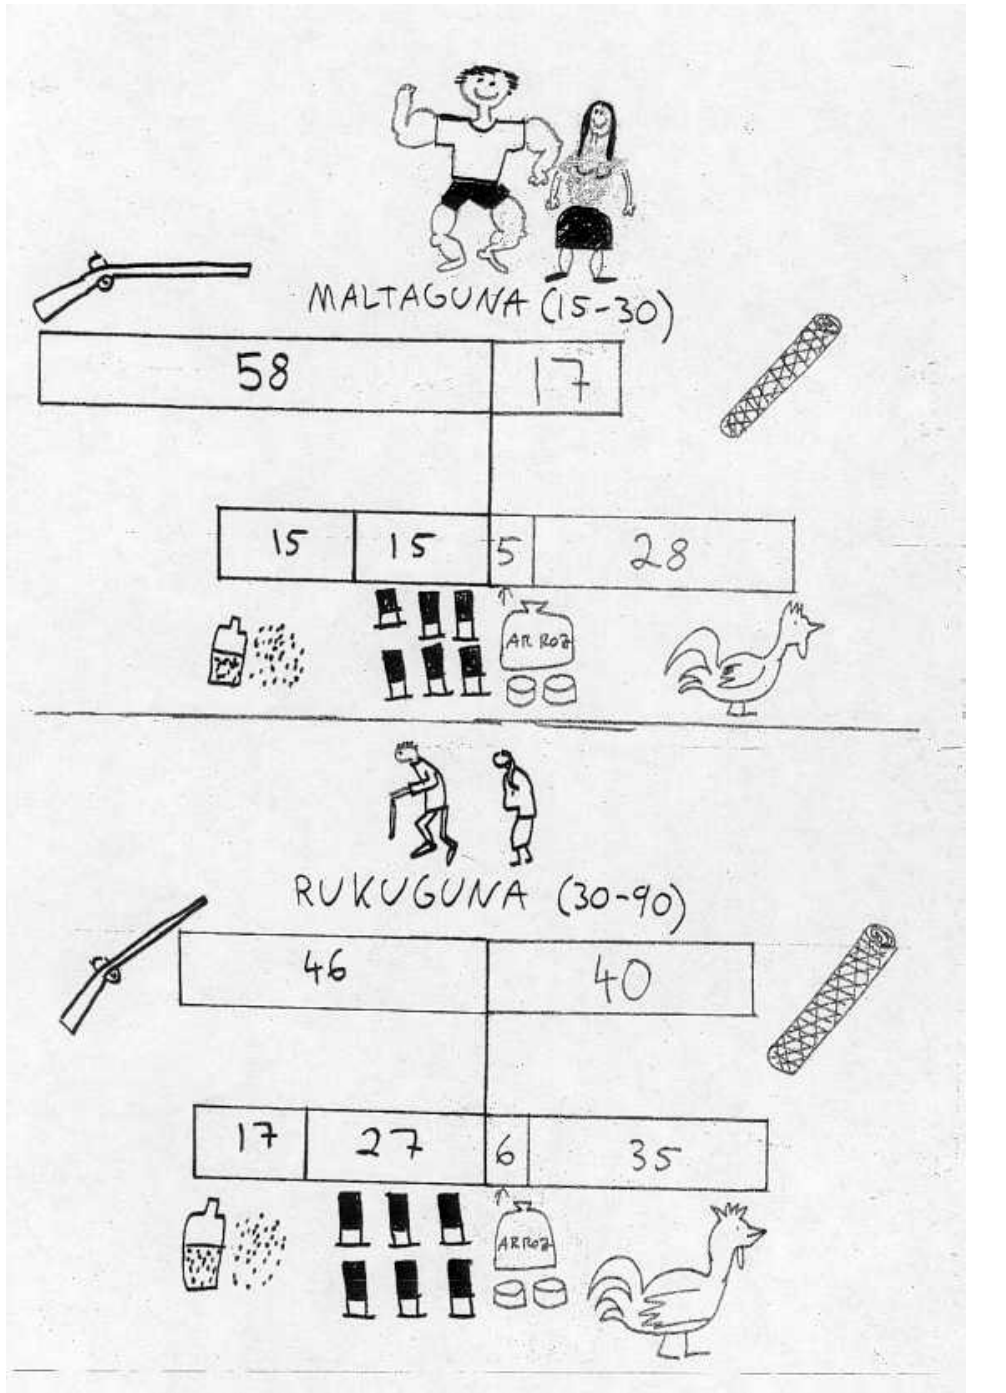
Fig. 4. Results split according to